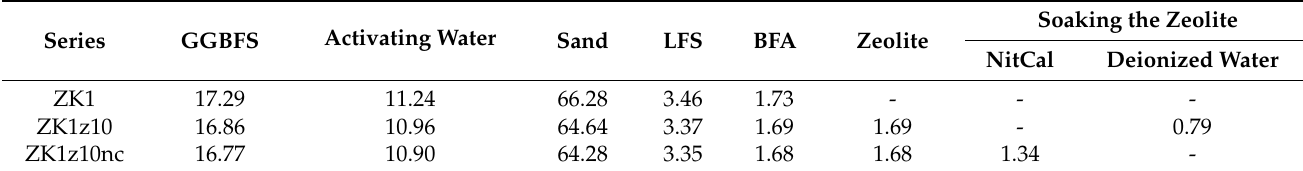
Table 6. Mixes of slag-ash mortars of 3 series, in percentage by mass.